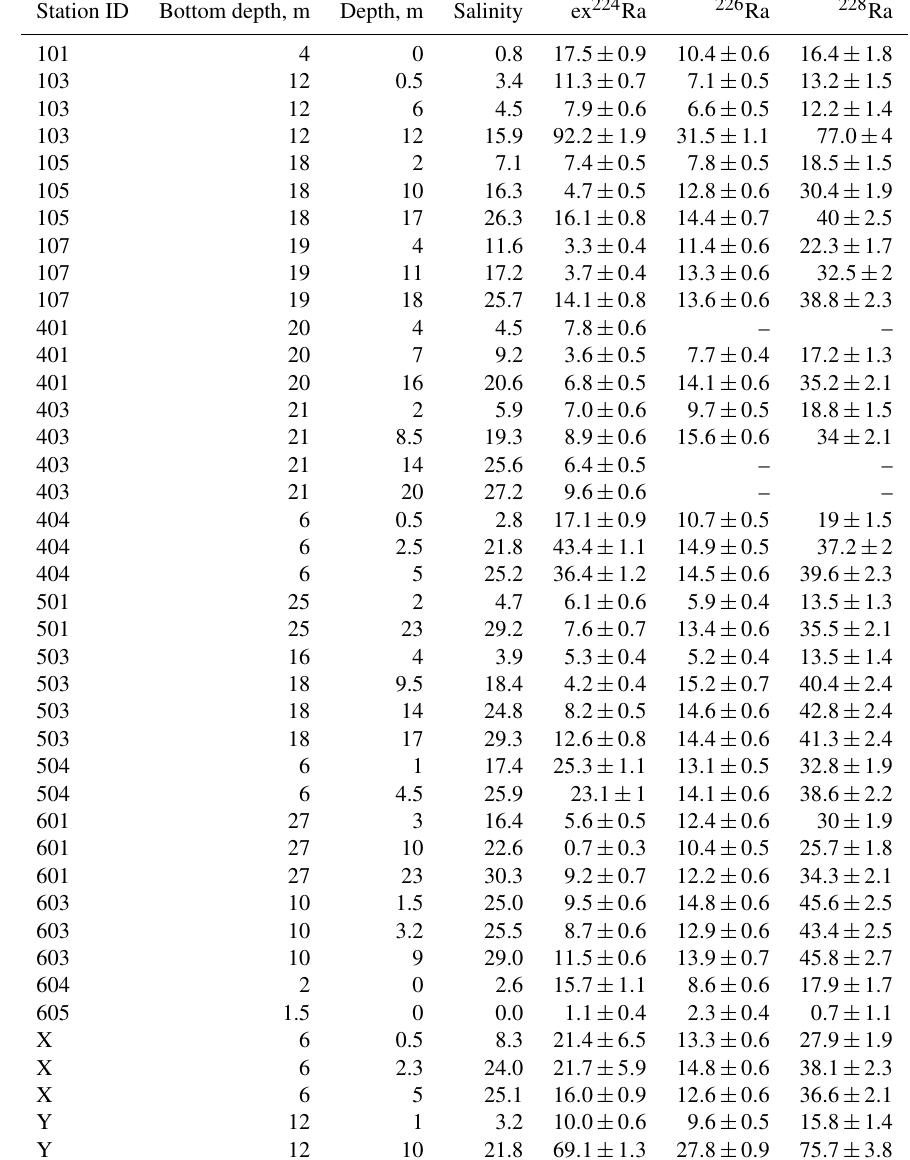
Table 2. Salinity, activities of radium isotopes ( 224 Ra, 226 Ra, 228 Ra, dpm100L − 1 ) in the wider delta area (Laptev Sea) during the summer